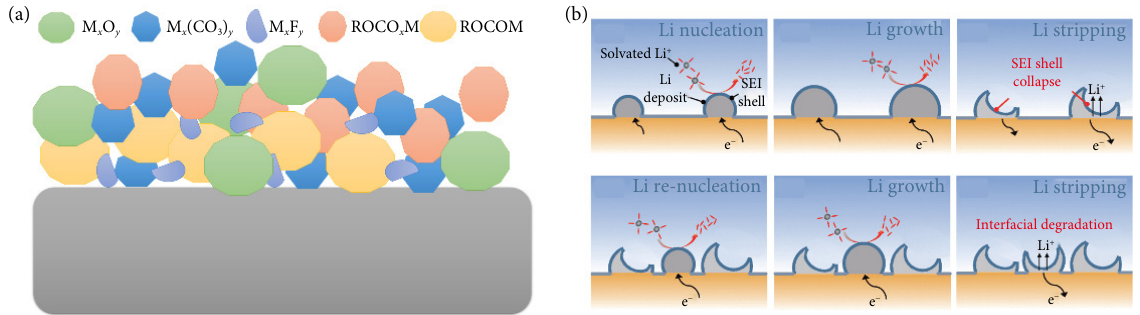
Fig. 3 (a) The composition of SEI. (b) Schematic diagram of SEI evolution during Li deposition/stripping at electrode/electrolyte interface (reprinted with